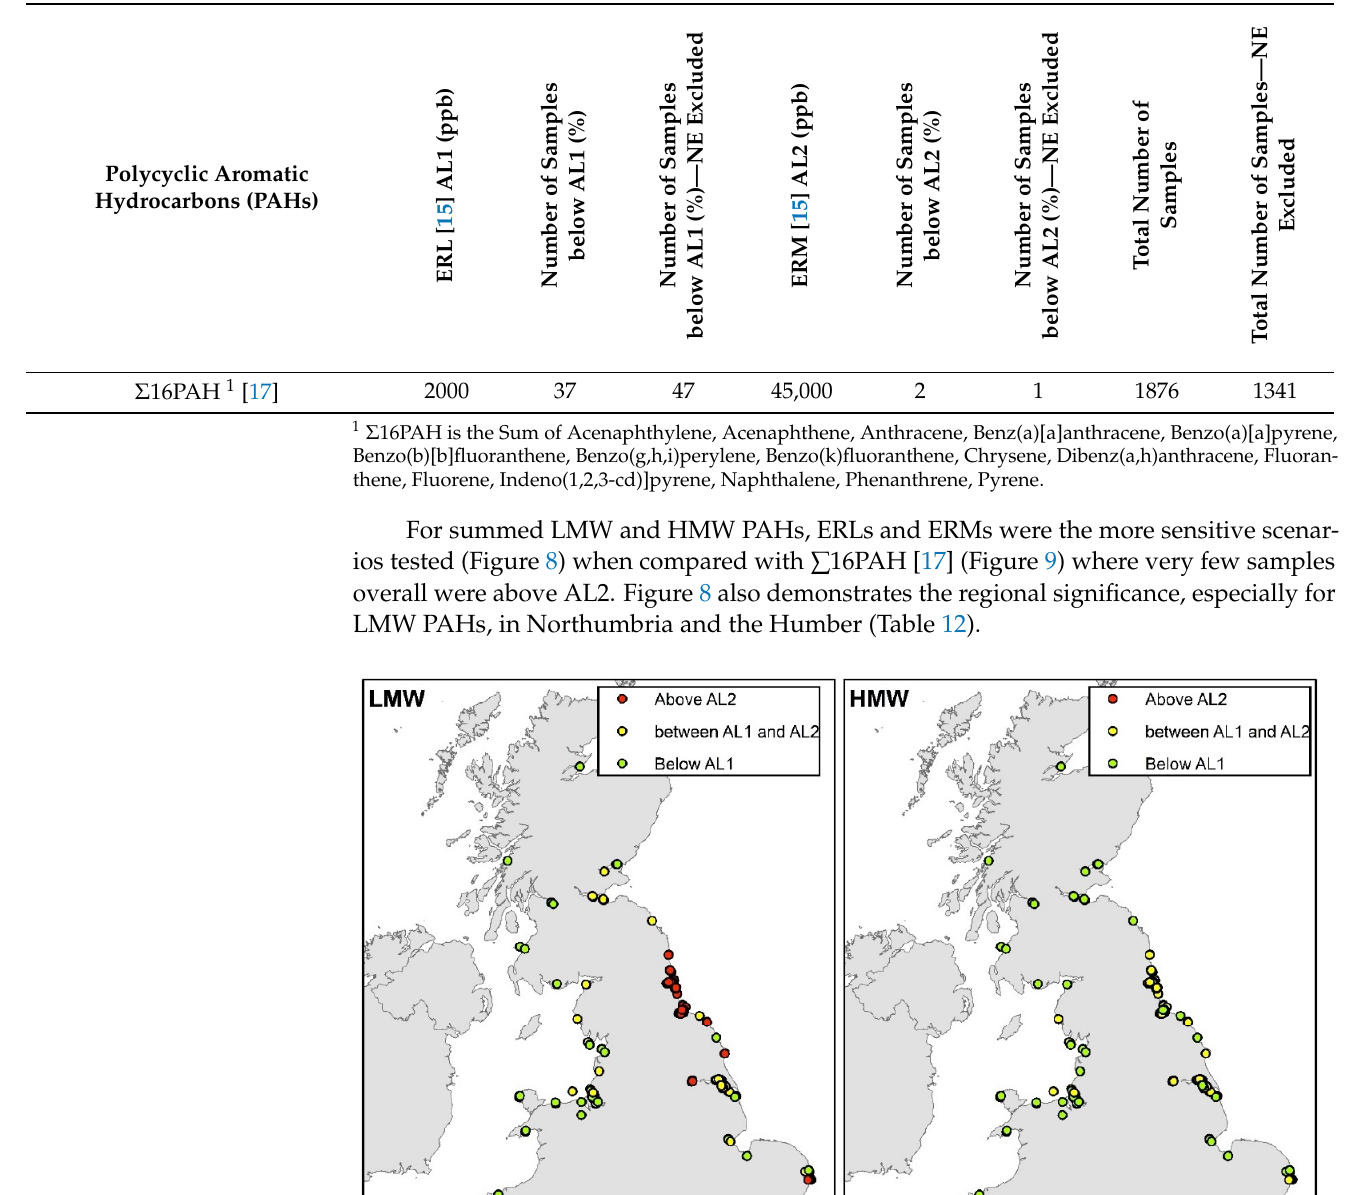
Table 13. Polycyclic Aromatic Hydrocarbons (PAHs)—Summed PAHs—Sum of 16 Polycyclic Aro- matic Hydrocarbons ( Σ 16PAH) [17]. Percentage of samples below AL1 and the percentage of samples with Northumbria and Humber samples excluded (NE excluded) are presented.